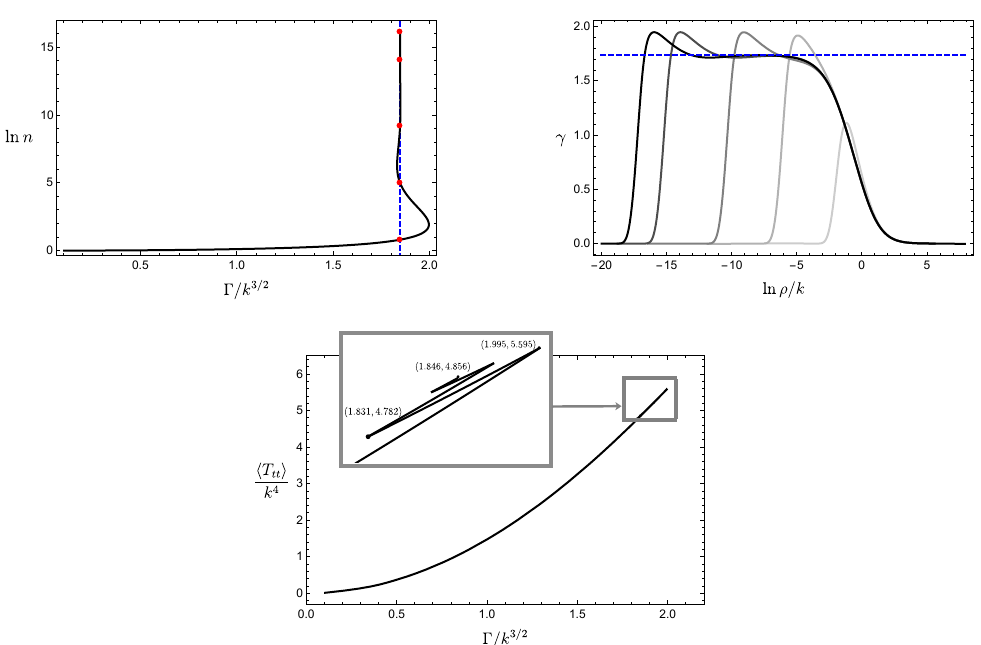
Figure 10 . Boomerang RG (cid:13)ows for m 2 = (cid:0) 15 = 4 and (cid:24) = (cid:0) 675 = 512. The upper left plot shows the refractive index n , de(cid:12)ned by (5.6), as a function of the deformation parameter (cid:0) =k 3 = 2 , for a one parameter family of boomerang RG (cid:13)ows. For the special value (cid:0) =k 3 = 2 = (cid:22)(cid:0) (cid:24) 1 : 8466 (dashed vertical line) there is also an AdS 0 to AdS 2 (cid:2) R 3 RG (cid:13)ow. Near (cid:0) =k 3 = 2 = (cid:22)(cid:0) the boomerang (cid:13)ows 5 are not uniquely speci(cid:12)ed by the value of (cid:0) =k 3 = 2 . As n becomes large the boomerang (cid:13)ows build up a large intermediate scaling regime dominated by the AdS 2 (cid:2) R 3 solution: for several boomerang (cid:13)ows with (cid:0) =k 3 = 2 (cid:24) 1 : 8466, denoted by red dots, we have plotted the radial behaviour of the scalar function in the upper right plot, with light grey to dark grey associated with increasing n , and the dashed horizontal line indicates the constant value of (cid:13) in the AdS 2 (cid:2) R 3 (cid:12)xed solution. The bottom plot shows the value of the energy for the boomerang (cid:13)ows and we see that for values of (cid:0) =k 3 = 2 where there is non-uniqueness, it is the solution with the smallest value of n that is preferred (the lightest grey in the upper right plot), and hence the intermediate AdS 2 (cid:2) R 3 scaling is frustrated.